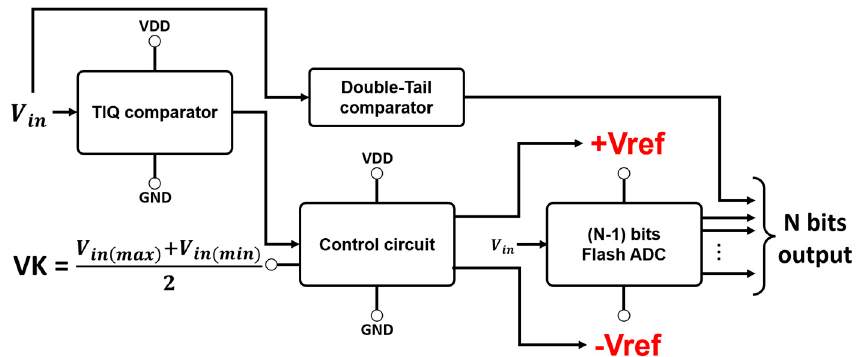
Figure 3. The proposed architecture of N-bit flash ADC.